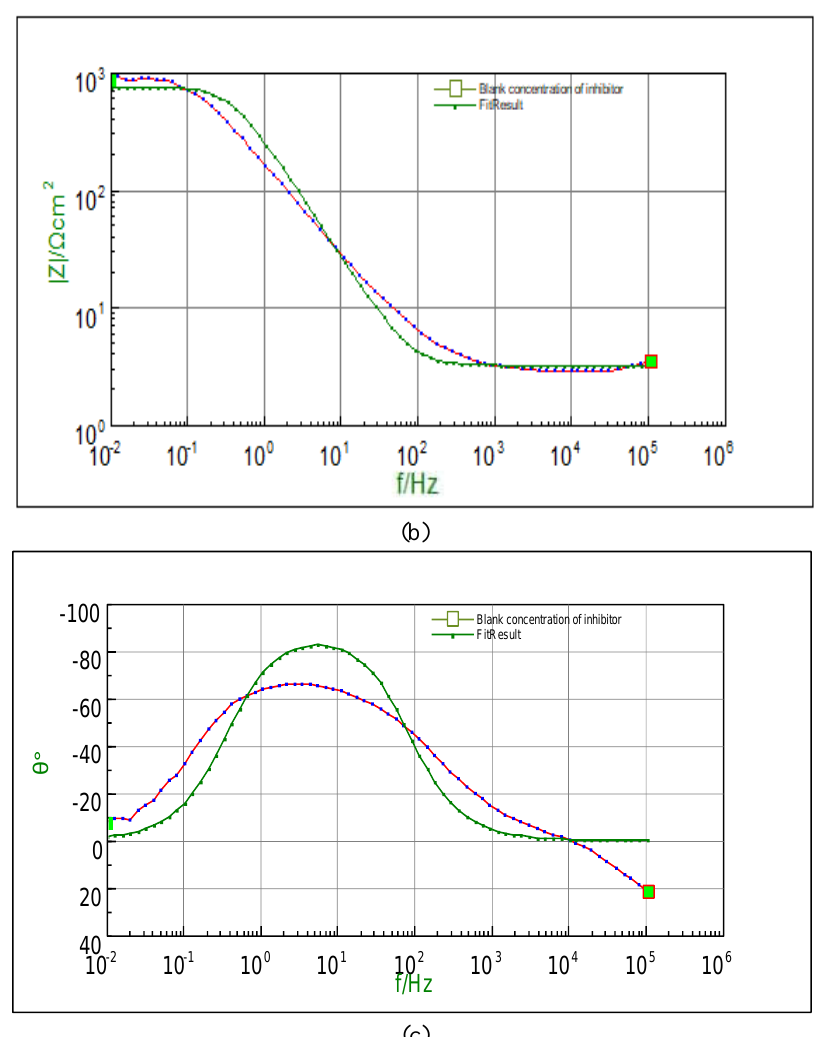
Fig. 9. The EIS test for blank concentration of inhibitor at 45◦C with the fitting result.. (a) Nyquist plot, (b, c) Bod (log versus |z|), and phase angle (log f versus ∝ 𝟎 )